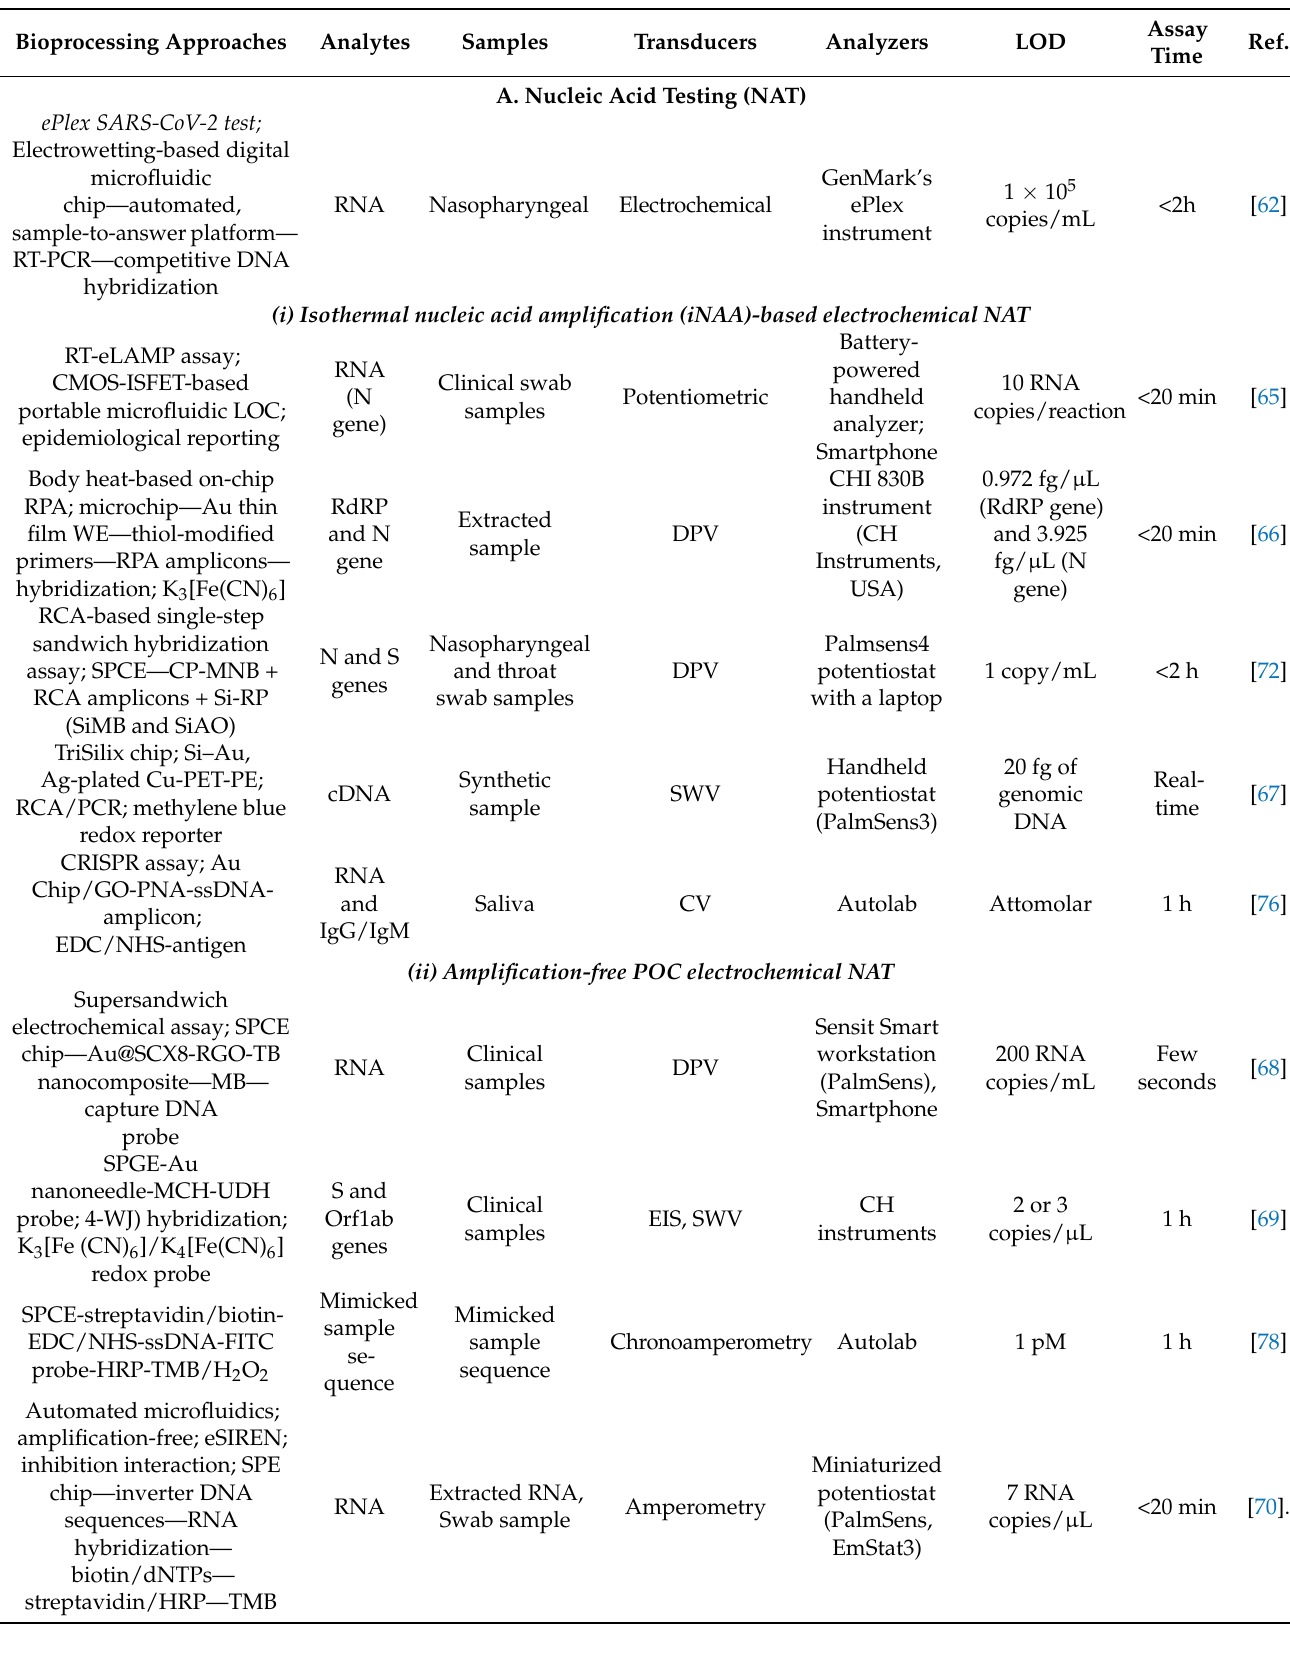
Table 1. Chip-based potential electrochemical biosensors for COVID-19